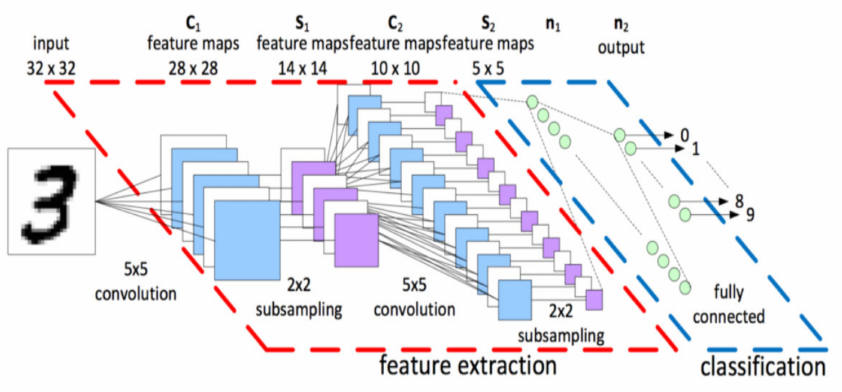
Figure 3. Convolution layer [7].